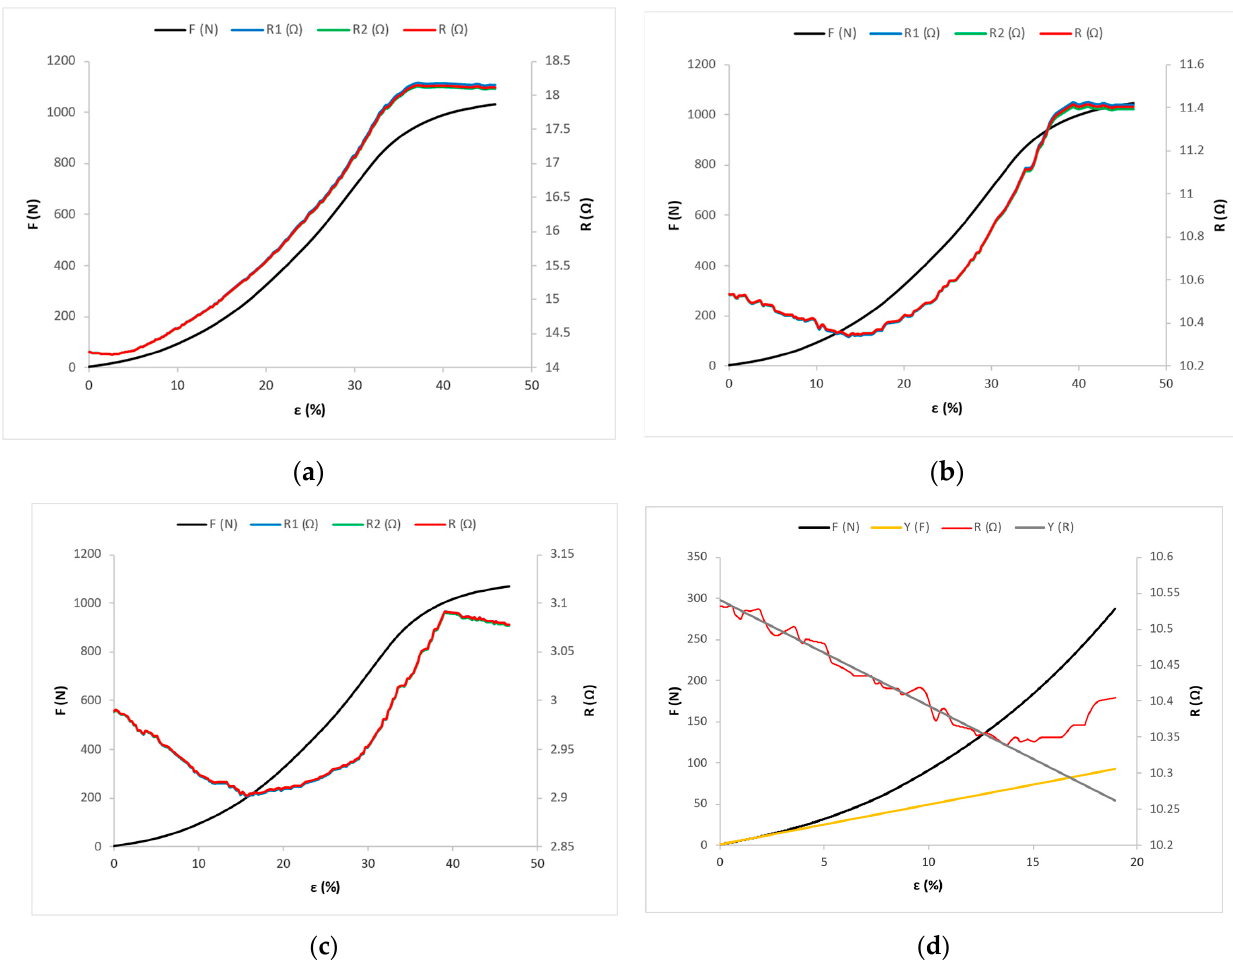
Figure 6. Force–elongation (F- ε ) and electrical resistance–elongation (R- ε ) diagrams for fabric samples cut in the warp direction: ( a ) for sample X-0; ( b ) for sample Y-0; and ( c ) for sample Z-0. ( d ) Experimental and mathematical models of F- ε and R- ε curves for sample Y-0.